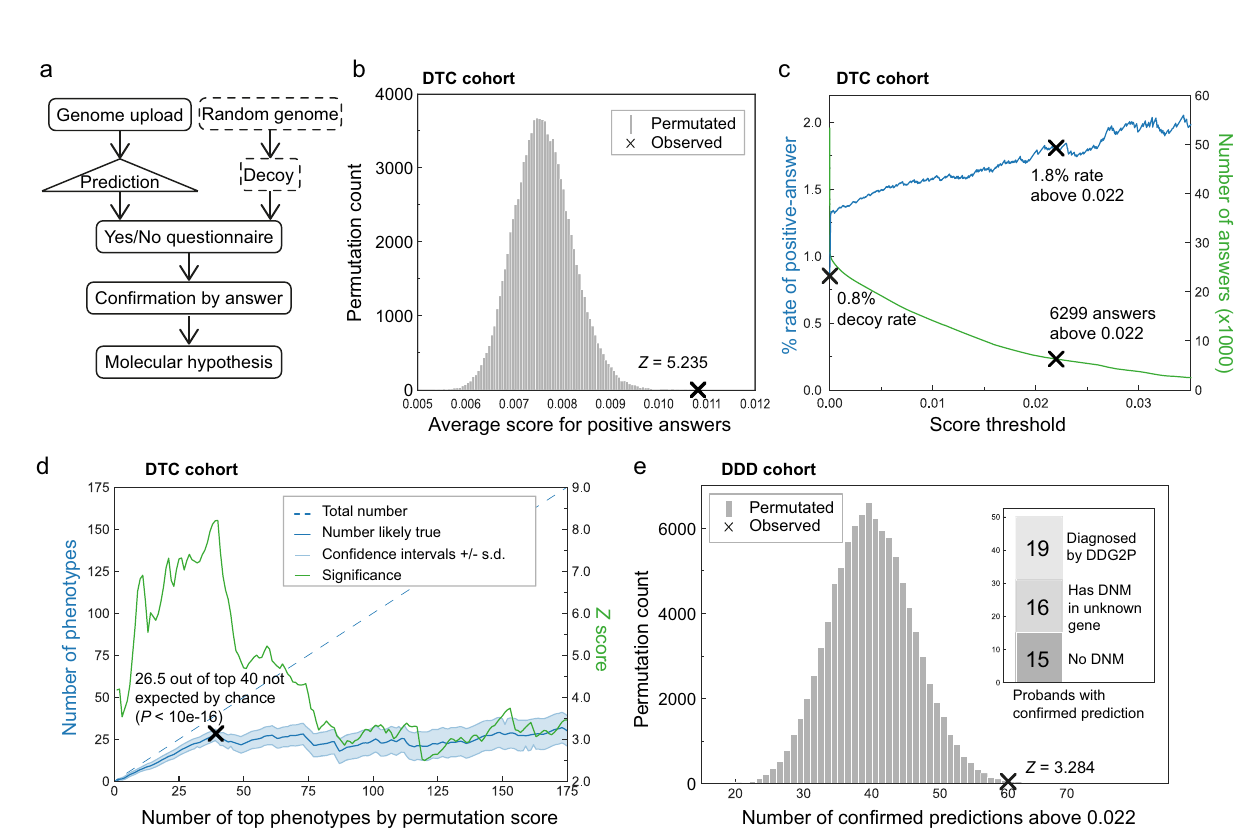
Fig. 2 | An outline of the genetics- fi rst analysis framework. – see methods for detail. Genome data is inputted at the top and causal hypotheses are outputted at the bottom. In the orange top box (algorithm), fi rstly the functional distance between each missense variant is derived from domain-based HMM probabilities, scaleddependingonzygosity(toprow).Subsequently(secondrow)variantsfalling in the region of a gene with homology to an HMM representing a functional unit (domain), are collated into a genetic pro fi le for a phenotype using domain- phenotype mappings inferred using dcGO 19 . This multi-domain collapsing of an ontology term can be likened to gene-based collapsing used in PheWAS 11 . Next